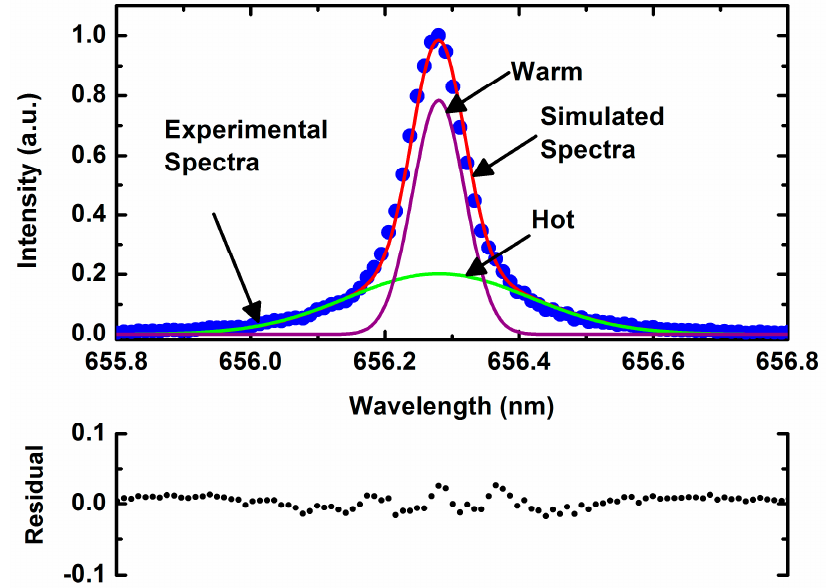
Figure 5. Fitting of the H α experimental spectrum with simulated spectra by considering all 48 Zeeman lines and two temperature components of the hydrogen atom.